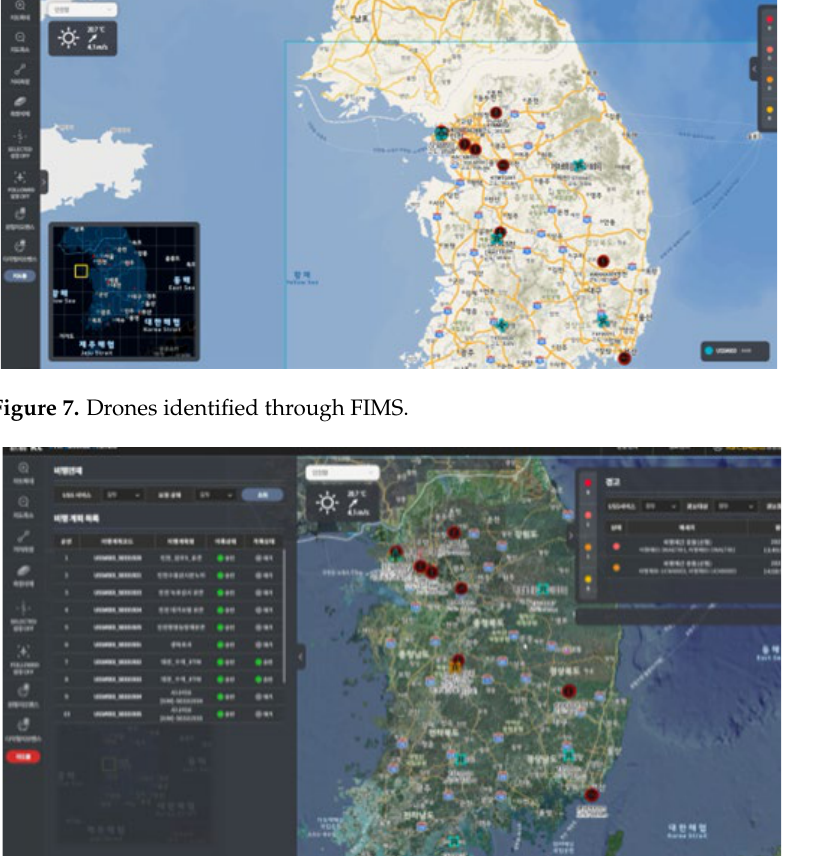
Table 7. 7 operators in 2021 K-Drone Demonstration Program.